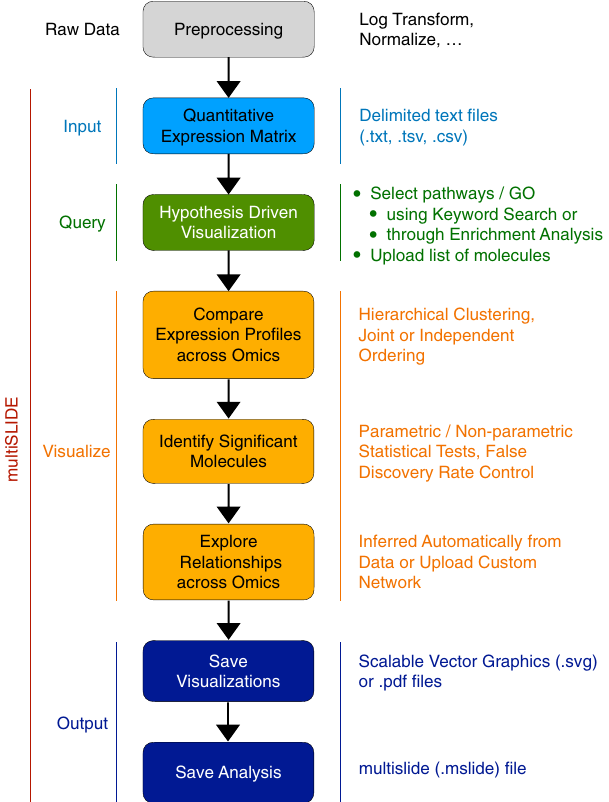
Fig. 1 Visualization work fl ow of multiSLIDE. Inputs to multiSLIDE are preprocessed quantitative expression pro fi les, formatted as delimited text fi les, with a separate fi le for each omics data. Users can select features to visualize, using keyword-based search, using the “ Upload Pathways ” option, or through enrichment analysis. Users can interact with the selected data using the many options for ordering/clustering of molecules and samples, as well as the customizable fi ltering of molecules based on differential expression levels. Once the exploration of the data reveals interesting patterns, users can save the visualizations as scalable vector graphics (SVG) or PDF fi les. The analysis workspace can also be saved as a.mslide fi le, retaining user selections and interactions, for sharing among collaborators. Snapshots of the visualization interface corresponding to this work fl ow are presented in Supplementary Fig.